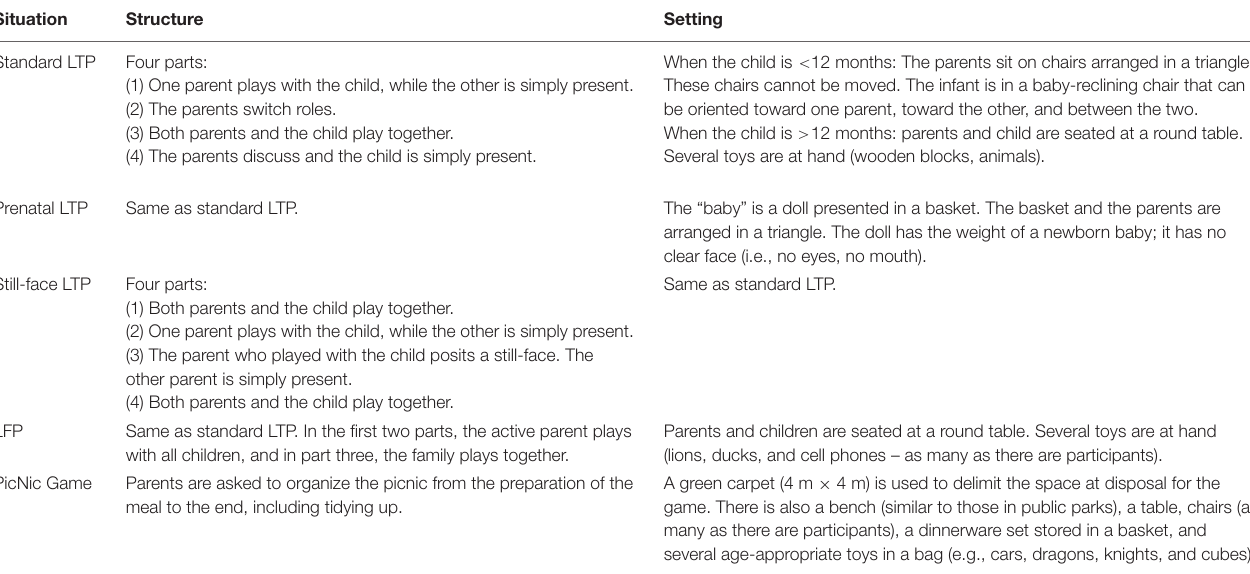
TABLE 1 | Summary of observational situations. Situation Structure Setting Standard